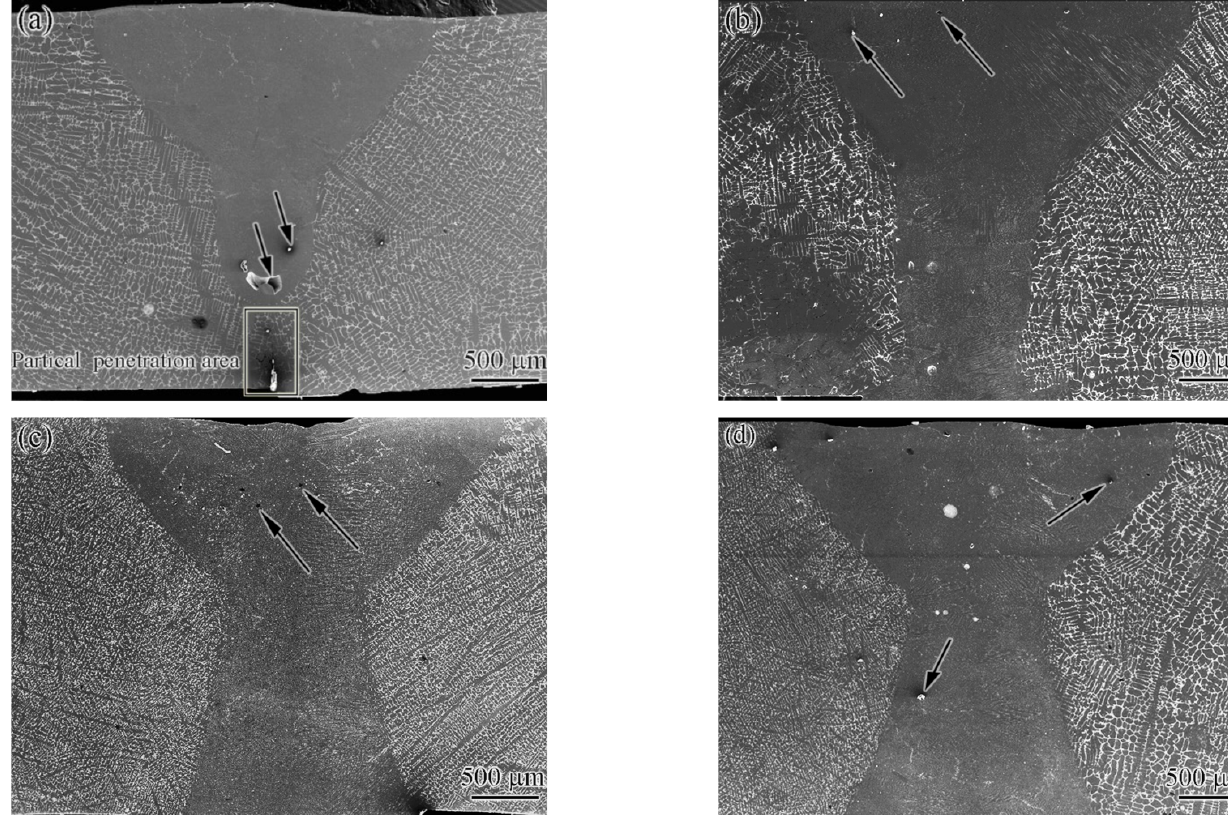
Figure 3. Macroscopic cross-section of SEM (secondary electron) images of the welded joint: ( a ) 1.65 kW, ( b ) 1.75 kW, ( c ) 1.85 kW, and ( d ) 1.95